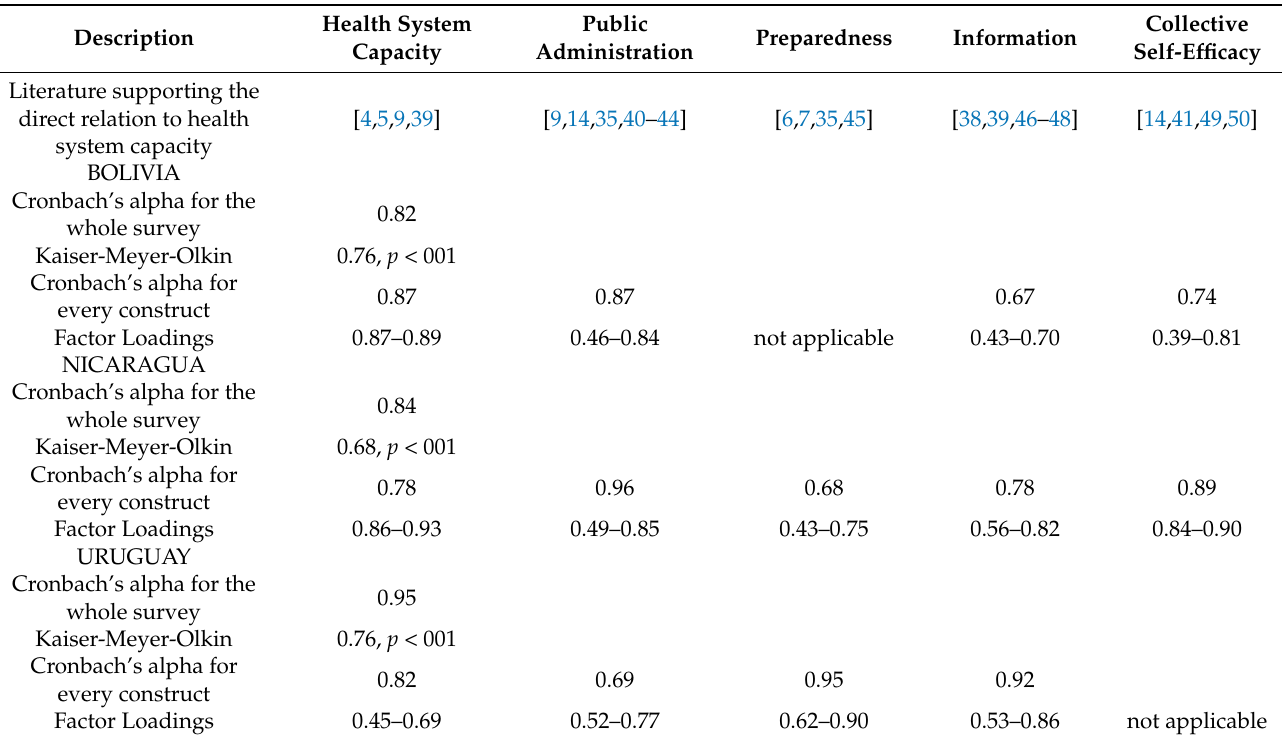
Table 2. Exploratory factor analysis and reliability per